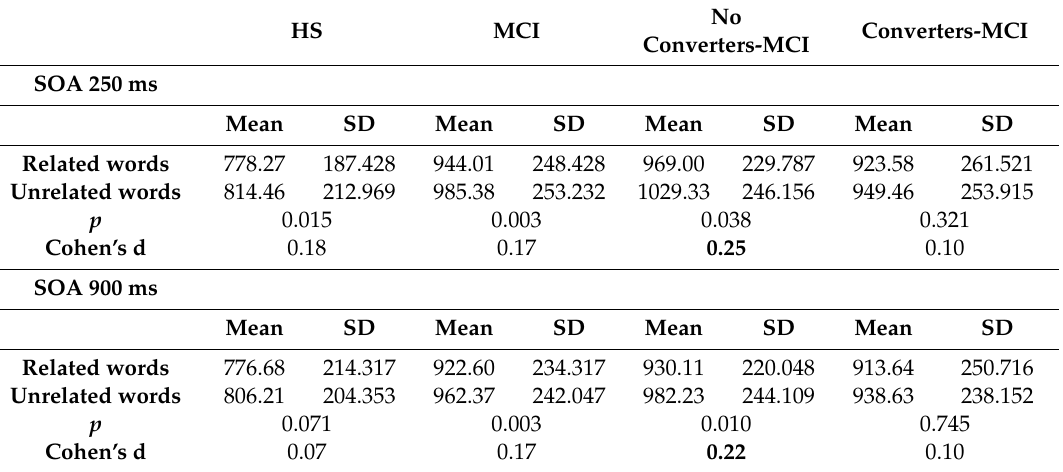
Table 2. Priming E ff ect at SOAs 250 ms and 900